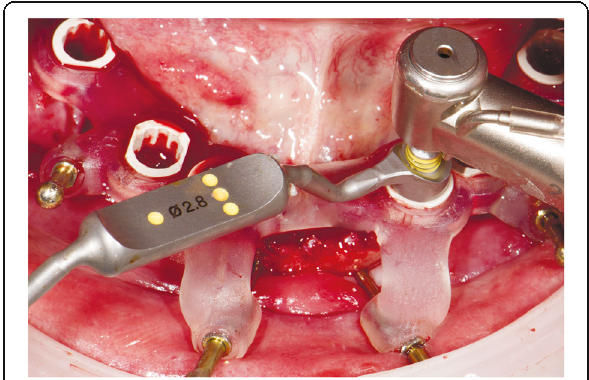
Fig. 12 Screw-retained abutments fixation on